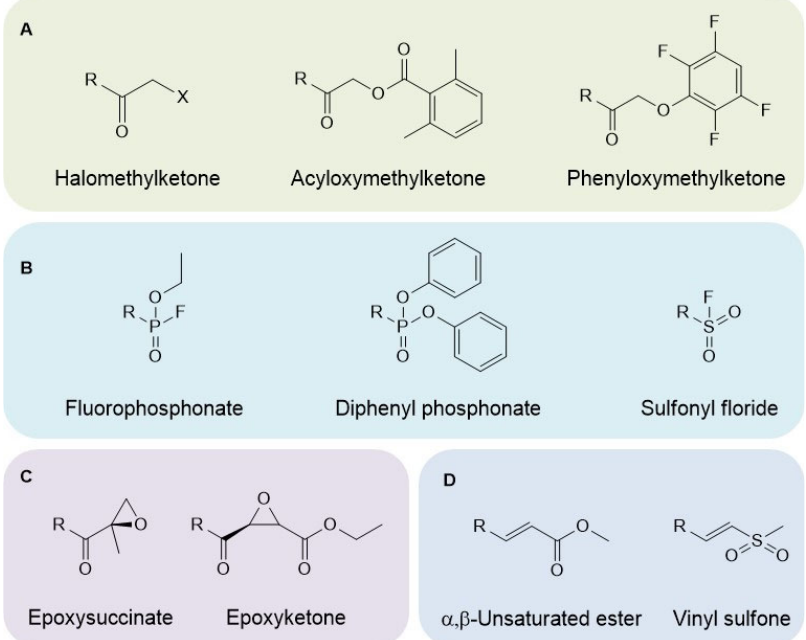
Figure 2. Chemical formulas of warheads used to target proteases. Phosphonates are the classical warheads for targeting serine proteases and acyloxymethyl ketones for cysteine proteases. ( A ), activated ketones. ( B ), phosphonates. ( C ), epoxides. ( D ), Michael acceptors.